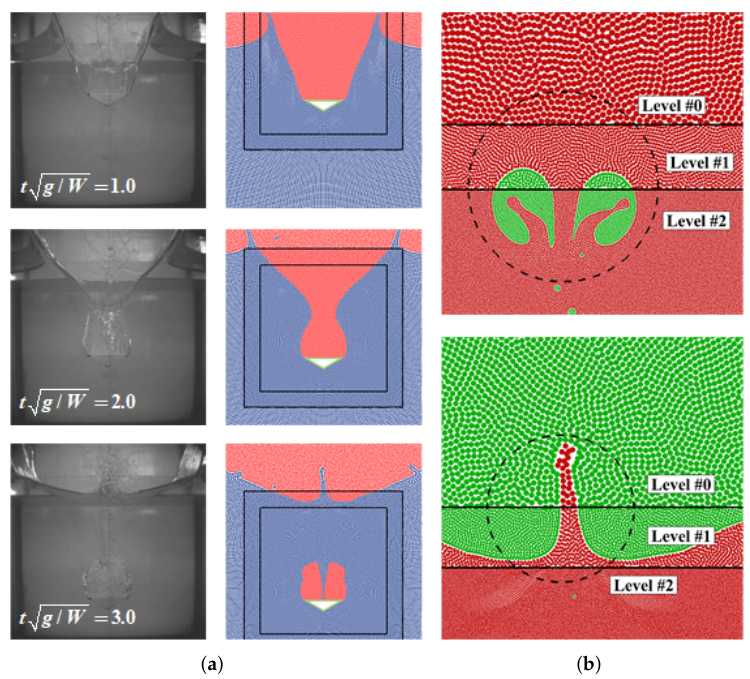
Figure 23. The water-entry process of a wedge simulated via a multiphase SPH model with APR, (cid:112) g / W is a nondimensional time variable. ( a ) The comparison between the experimental where t snapshots [249] and SPH results [87]. ( b ) The local flow field of the rising bubbles and Worthington